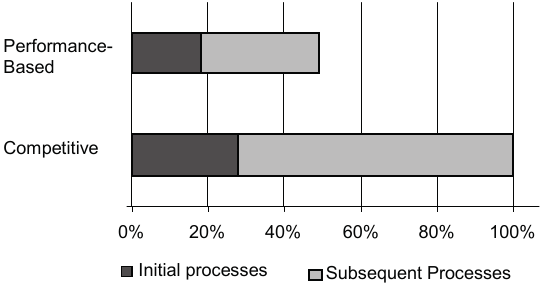
Figure 2. Average indirect costs of initial processes and of subsequent